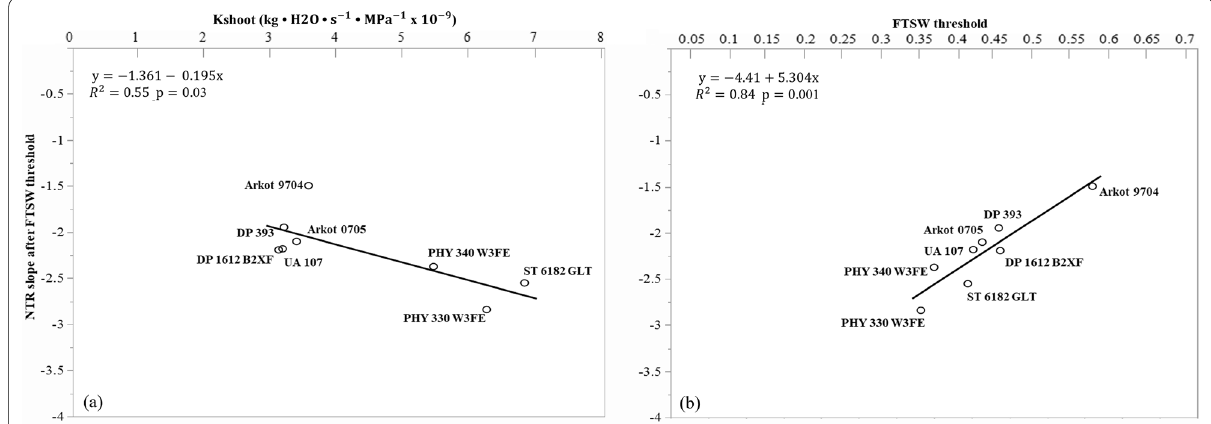
Fig. 4 Graphs of values of shoot hydraulic conductance (K shoot ) under a high evaporative demand [38 °C, vapor pressure deficit (VPD) > 3 kPa] in a controlled environment ( a ) and the fraction of transpirable soil water (FTSW) threshold under progressive soil drying ( b ) versus the normalized transpiration rate (NTR) slope after FTSW threshold. R 2